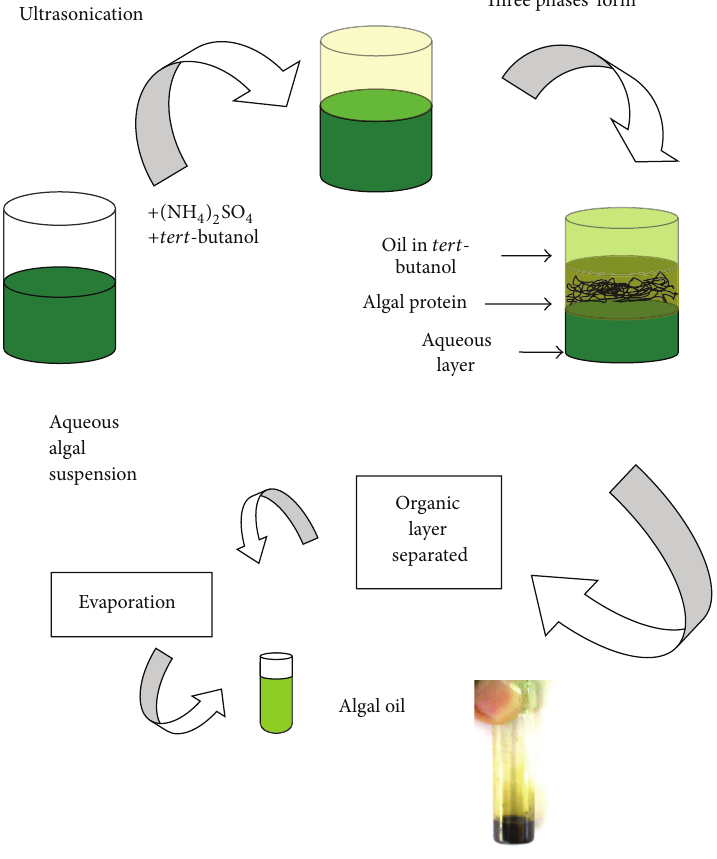
Scheme 1: Extraction of algal oil by Three-Phase Partitioning (TPP).